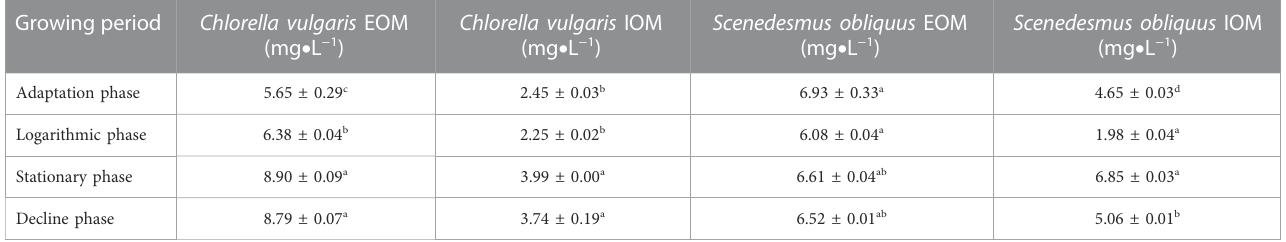
TABLE 1 Values of dissolved organic carbon (DOC/mg Growing period